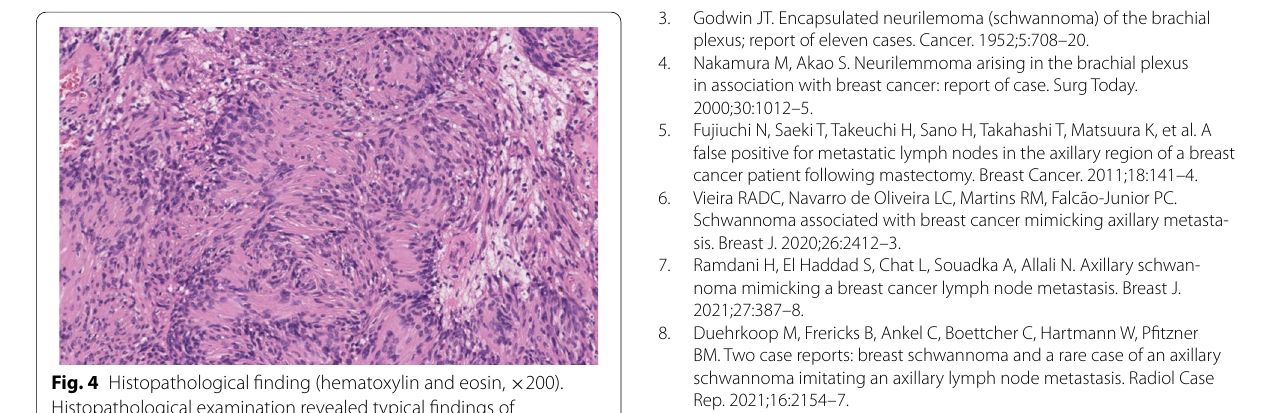
Fig. 4 Histopathological finding (hematoxylin and eosin, Histopathological examination revealed typical findings of schwannoma, such as spindle-shaped cells with palisading nuclei and biphasic growth patterns (Antoni type A and